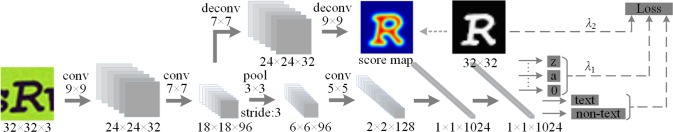
Architecture of text CNN [21].